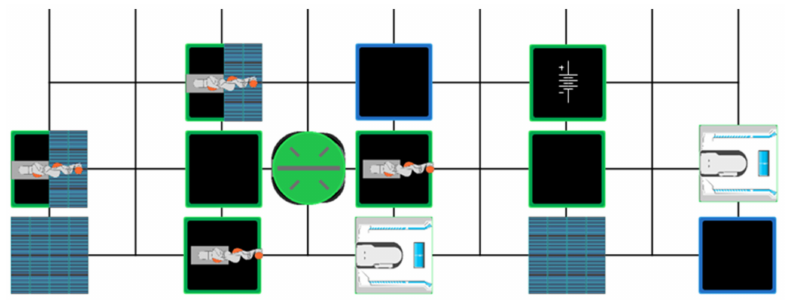
Figure 5. Multi-row random distribution of platforms with access